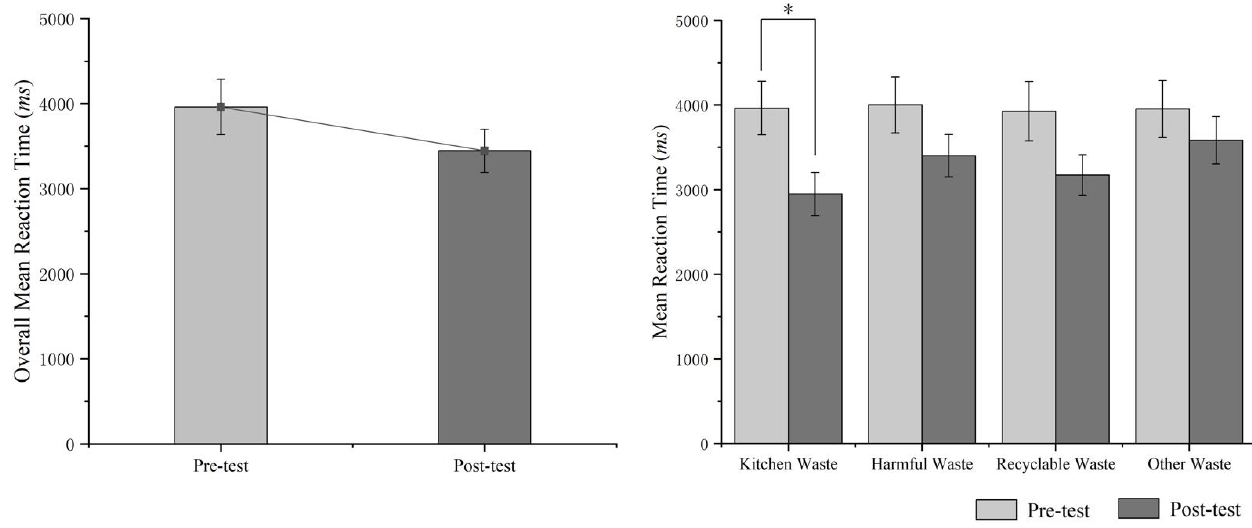
Figure 7. Comparison of reaction duration between pre-test and post-test. * p < 0.05